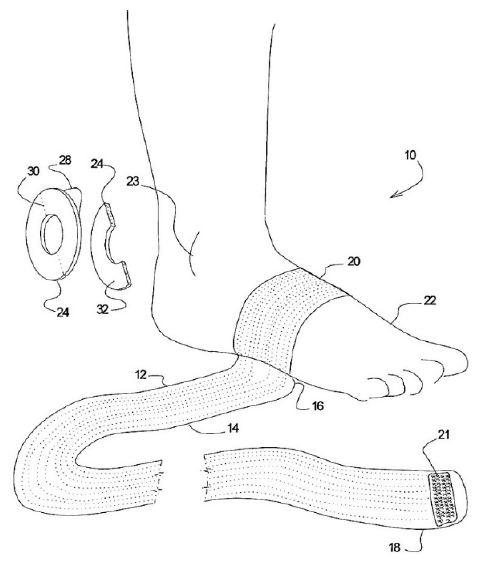
Figure 9. Ankle Wrapping System